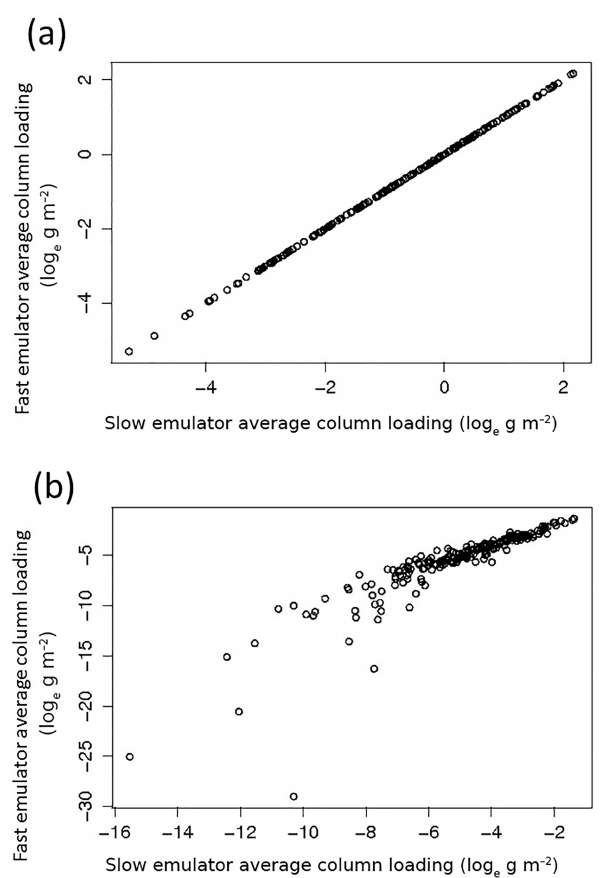
Figure 3. Relationship between the slow simulator and fast simula- tor output for X S at (first graph) the first region and (second graph) the 63rd region (third region at 19:00UTC). The 63rd region has the lowest correlation between fast and slow simulator